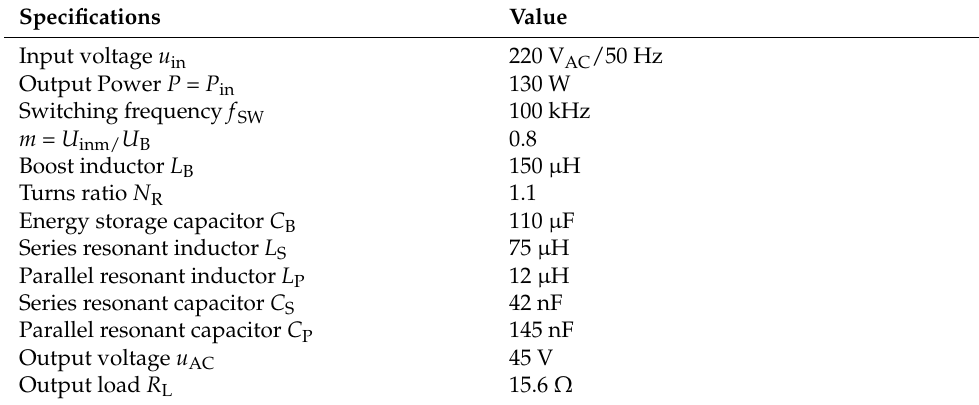
Table 2. Prototype